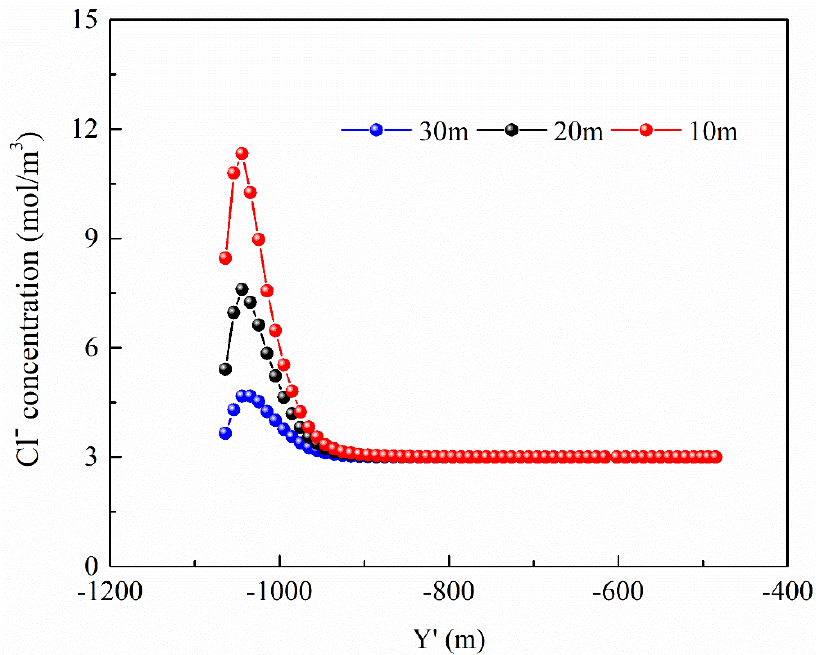
Figure 24. Cl − concentration along the central axis of the Cavern #2 bottom with different vertical water curtain depths.